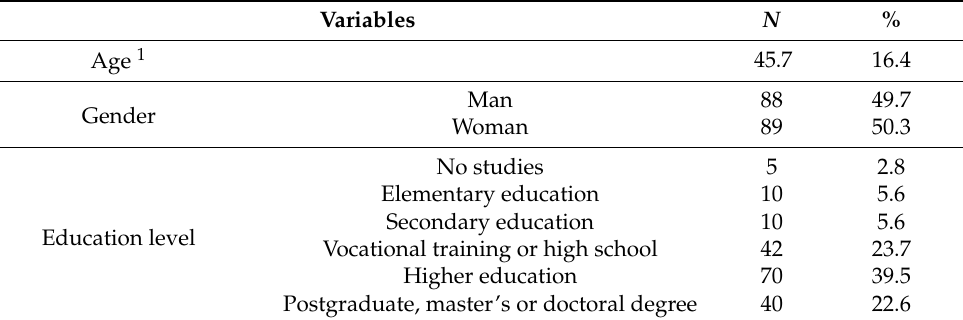
Table 1. Sociodemographic characteristics. N =